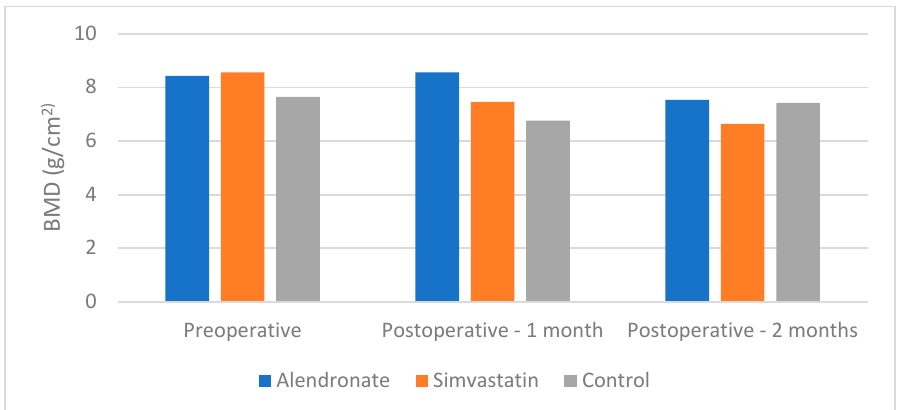
Figure 4. DEXA scans overall values of the affected hip preoperatively, postoperatively at one month, and postoperatively at two months.